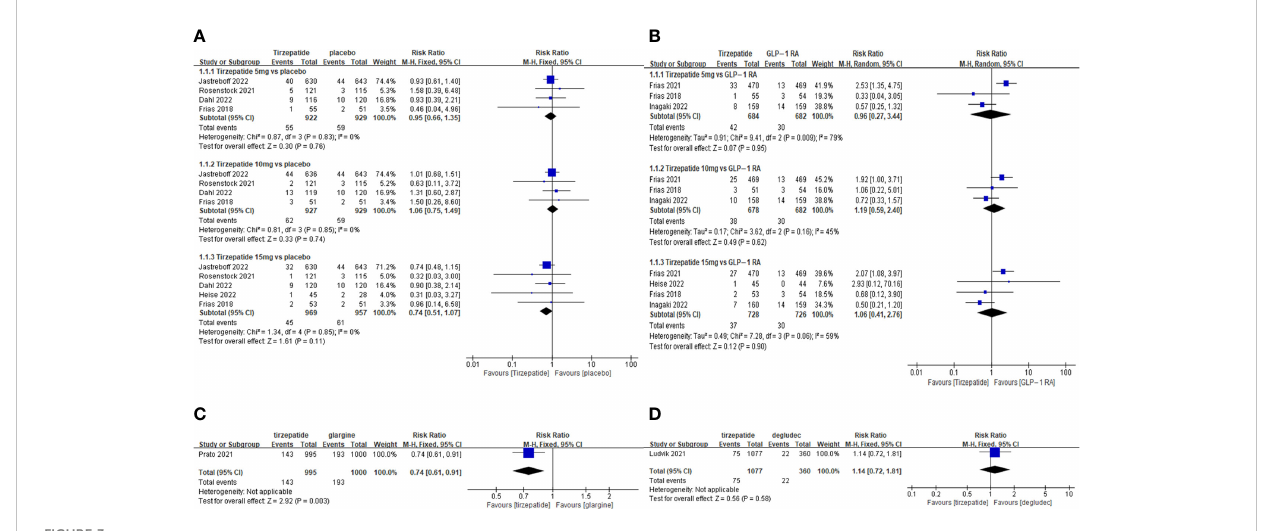
FIGURE 3 Meta-analysis results for tirzepatide of serious adverse drug event: (A) tirzepatide vs placebo. (B) tirzepatide vs GLP-1RAs. (C) tirzepatide vs insulin glargine. (D) tirzepatide vs insulin degludec.